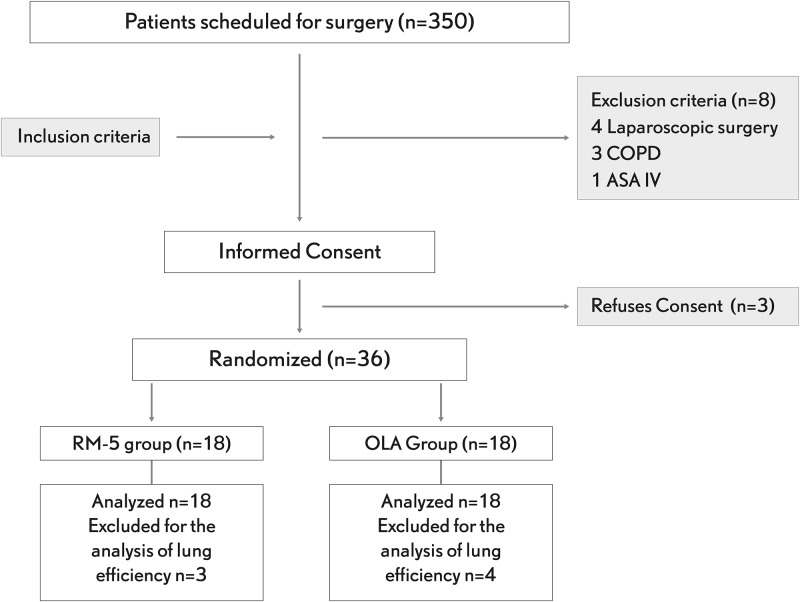
CONSORT flow diagram.COPD: chronic obstructive pulmonary disease, ASA: American Society of Anesthesiology physical status, RM: recruitment maneuver, OLA: open-lung approach.